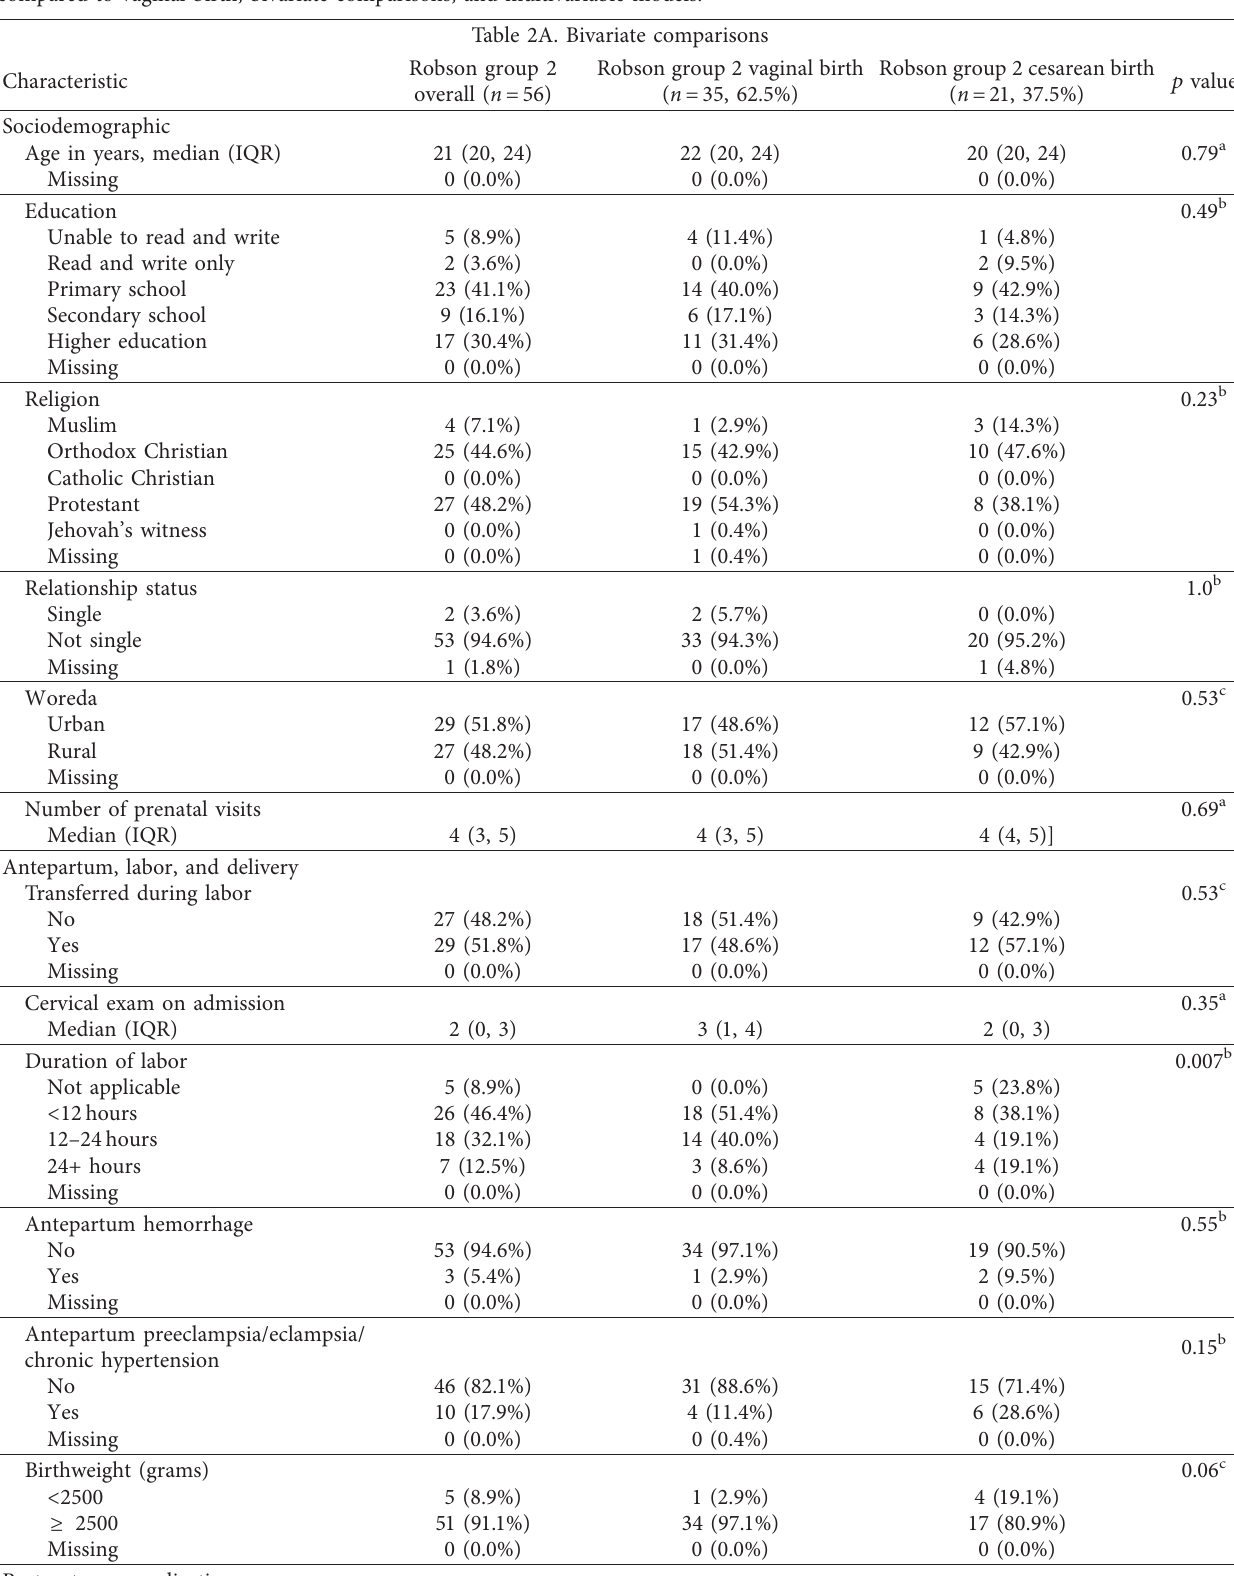
Table 2: Sociodemographic, obstetric, labor, and delivery characteristics of Robson Group 2 women who experienced cesarean birth compared to vaginal birth, bivariate comparisons, and multivariable models. Table 2A. Bivariate